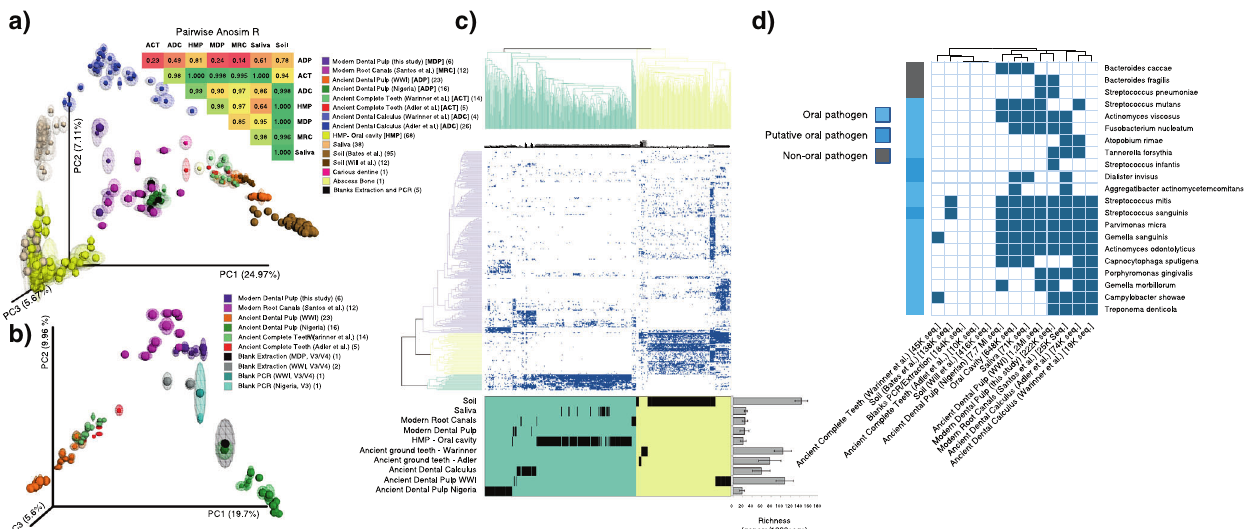
Fig. 1. Tracking back oral microbes in ancient and modern dental pulps. a PCoA based on UU distances using a reference-based OTU table. Distances between samples were calculated on 100 repetitions of evenly rare fi ed OTU tables and the halo around each sample indicate the dispersion among repetitions. Samples were colored according to the data set of origin and the references are embedded in the fi gure. Bigger spheres correspond to long amplicons (V3/V4 region of the 16S rRNA) and smaller spheres to short amplicons (V3 region). Numbers in parentheses indicate the number of samples for each data set and the general category of each is indicated in square brackets . Using the UU distance matrices, the eight main categories of samples were mutually compared using a pairwise ANalysis Of SIMilarity (ANOSIM) statistical test and the resulting R -values are shown on top of PCoA. The p -values obtained in all analyses were always lower than 0.01. b All teeth samples were retrieved from the reference-based OTU table, and the resulting table was evenly rare fi ed 100 times. The UU distance was calculated on these repetitions and plotted using PCoA using same procedures as in a . c Heatmap analysis showing the genera detected (presence/absence) in at least 10 samples from the total analyzed. All sequences from each data set were used in the analysis. Genera found in blanks of polymerase chain reaction (PCR) and extraction were excluded from the analysis. The Jaccard distance was used to sort samples and genera. Richness was estimated using an even rarefaction of the reference-based OTU table at 1000 sequences per sample and counting the number of known genera observed for each sample. Unknown or uncultured environmental bacteria were not considered. Richness values and error bars correspond to averages and standard deviations, respectively, between all samples within a category. d All sequences from each data set were compared by BlastN against the 16S rRNA sequences of known pathogens in PATRIC database. The numbers of sequences used in the analysis are indicated in square brackets . Only sequences that showed a 100 % similarity against a pathogen sequence with at least 60 % of the read aligned were considered. As an additional fi lter, these sequences were then compared against the full NCBI database and only sequences that showed 100 % similarity against non-ambiguous species (i.e., only showed perfect hit against the same species that in PATRIC DB) were conserved. Bacteria that are commonly associated with oral pathologies are indicated in light blue on the left of the fi gure. Three bacterial species that are commonly isolated from the oral cavity but their role in oral pathogenesis has been only suspected are colored in dark blue . Pathogens from non-oral pathologies are indicated in gray . Samples were grouped by data set and a positive hit was considered when a pathogen was con fi dently found in at least one sample from that data